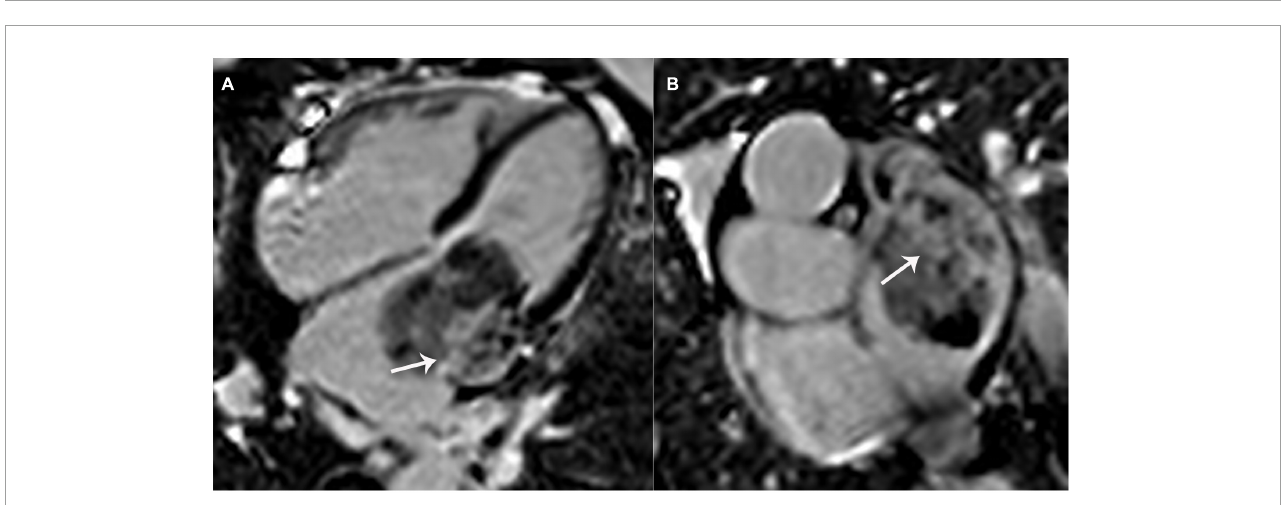
FIGURE4 Left atrial mass on late gadolinium-enhanced (LGE) imaging. Significant patchy enhancement (white arrows) was observed on LGE images. (A) 4-chamber view; (B) a shot-axis view of left